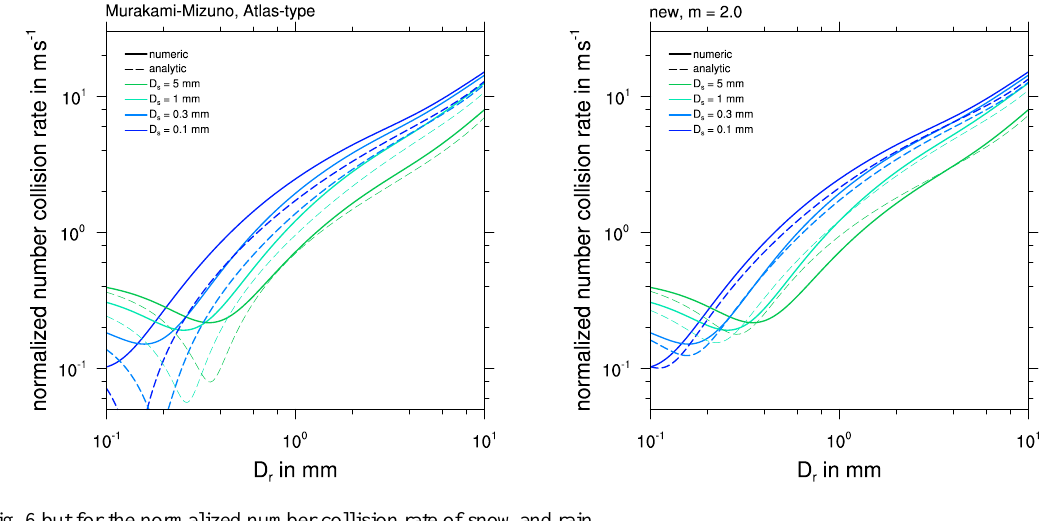
Fig. 7. As Fig. 6 but for the normalized number collision rate of snow and Fig. 7. As Fig. 6, but for the normalized number collision rate of snow and rain.